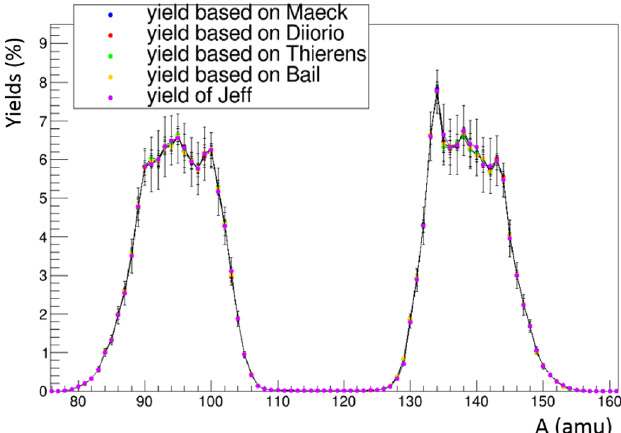
Fig. 4. Evaluations of 235 U( n th , f ) mass yields based on reference data sets. A very good agreement between evaluations and the JEFF3.1 library is observed.